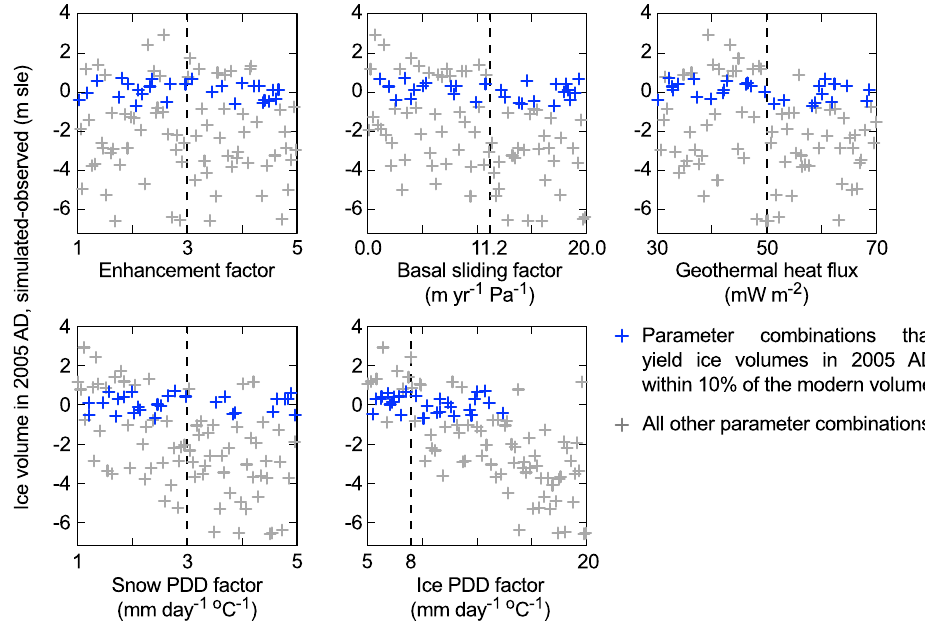
Fig. 5. Relation between input parameter values and simulated ice volumes in 2005 AD for all ensemble members (gray crosses) and runs that lie within 10% of the estimated modern ice volume (blue crosses). Vertical dashed lines indicate EISMINT-3 best estimates for most model parameters (Huybrechts, 1998; Stone et al., 2010) except the basal sliding factor, which comes from Greve and Otsu (2007). Influential parameters are indicated by points that are tightly arranged about a curve that dips steeply from one side of the plot to the other (Saltelli et al., 2008). In our ensemble, the ice positive degree-day factor has the greatest influence on simulated modern ice volume, with the snow PDD factor and the basal sliding factor taking second and third places. However, ice PDD factors greater than ∼ 15mmday − 1 ◦ C − 1 appear inconsistent with the modern ice volume constraint.